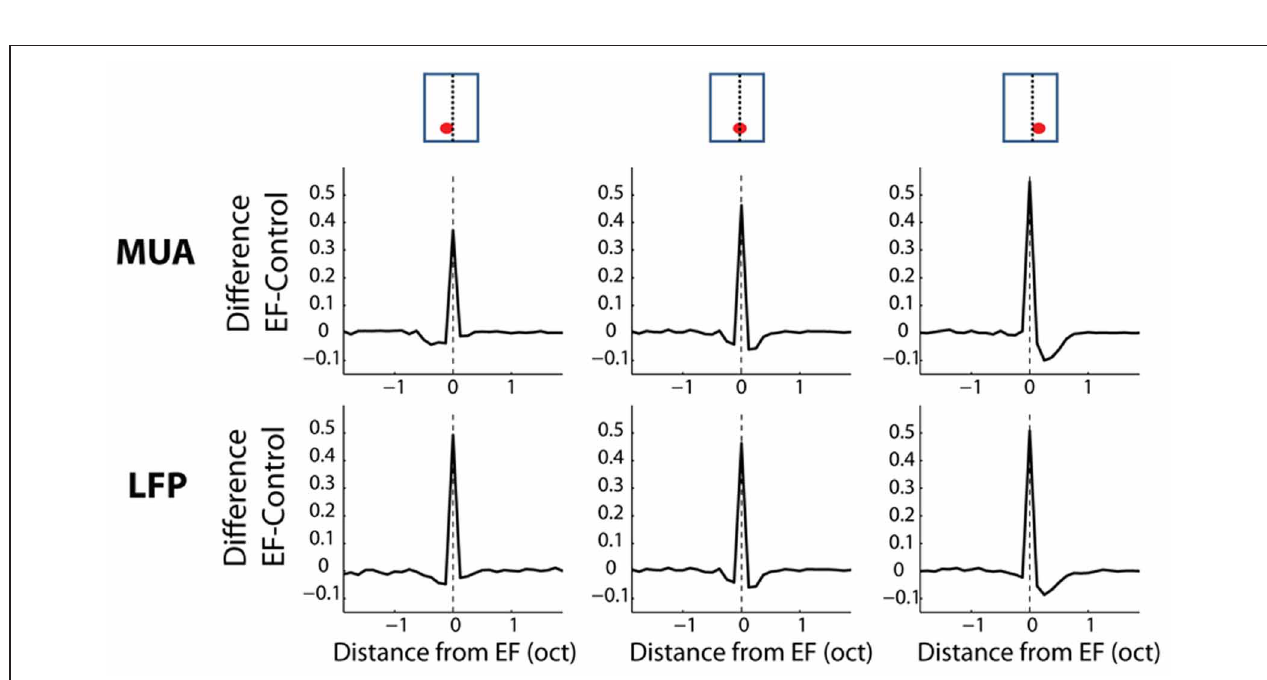
AFB). Positive values indicate increased width, while negative values indicate decreased width. The width of the “excitation patterns” gives an estimate of the number of neurons involved in the representation of a given frequency.